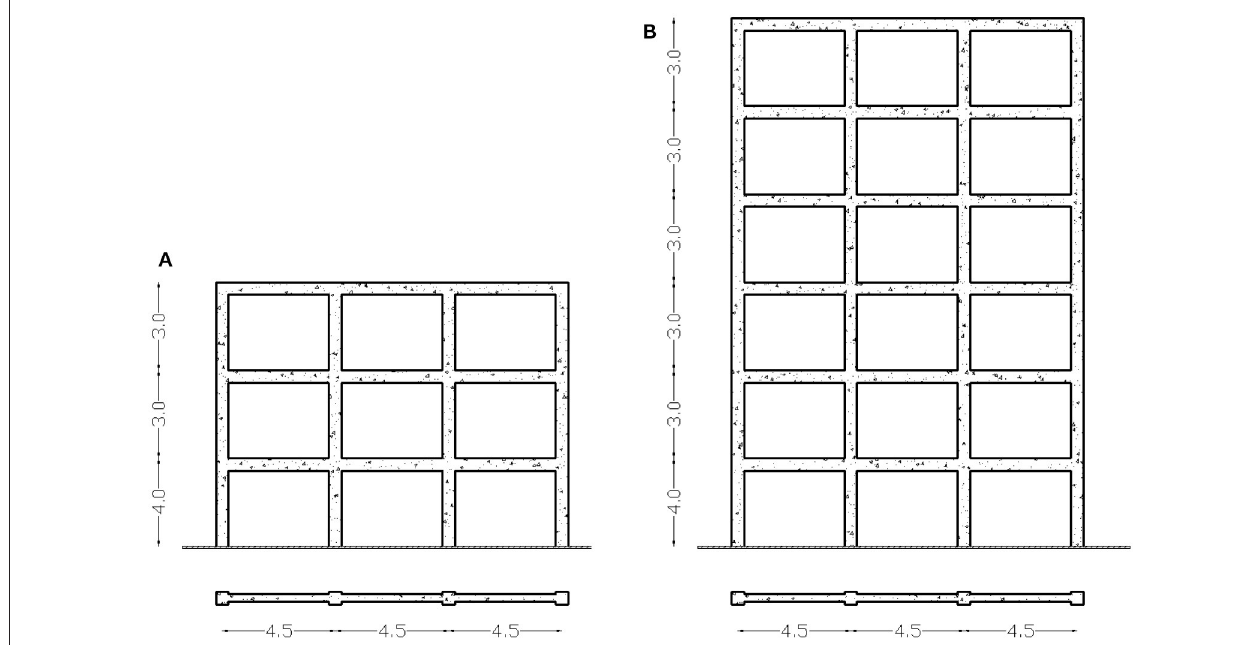
FIGURE 3 | RC test examples— (A) three-story and (B) six-story.